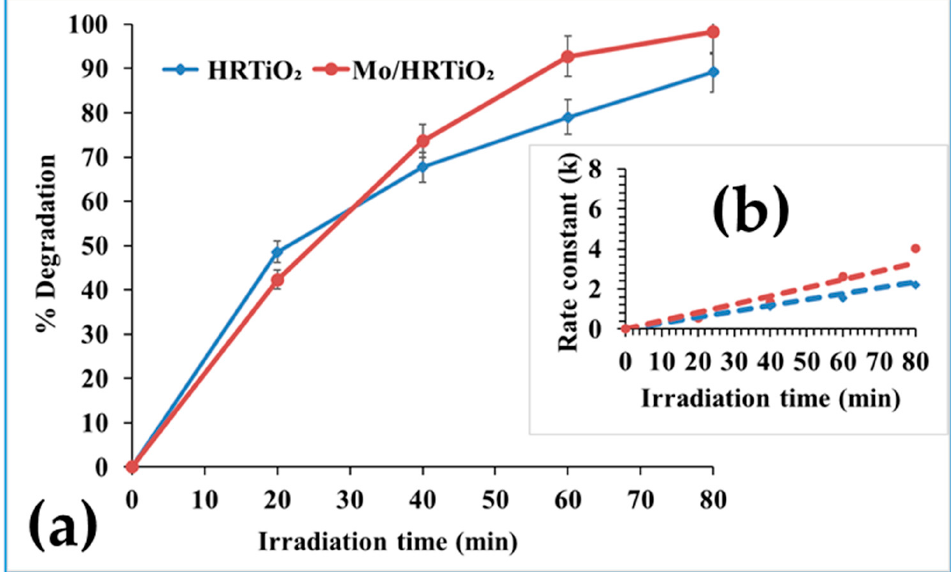
Figure 10. ( a ) Preliminary photocatalytic test performance of HRTiO 2 (blue line) and Mo/HRTiO 2 (red line), and ( b ) their corresponding photocatalytic degradation rate constant (k) under test condi- tions of 1 g/L catalyst dosage, 50 mg/L initial IBU concentration, initial natural (unmodified) pH 4, and 365 nm UV